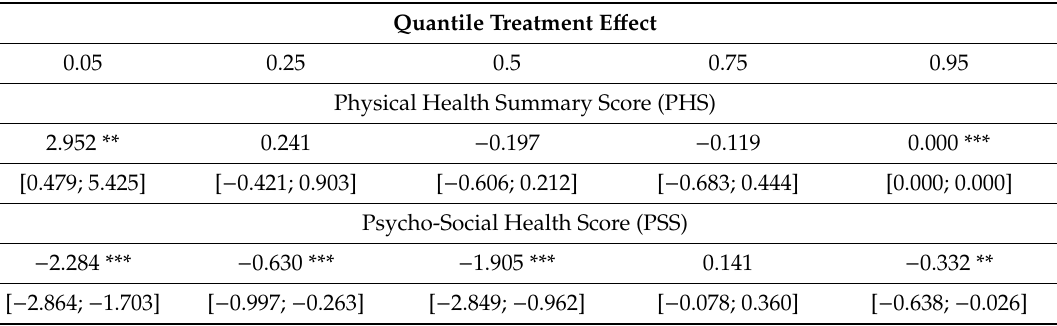
Table 3. Summary of quantile treatment e ff ect of residential instability